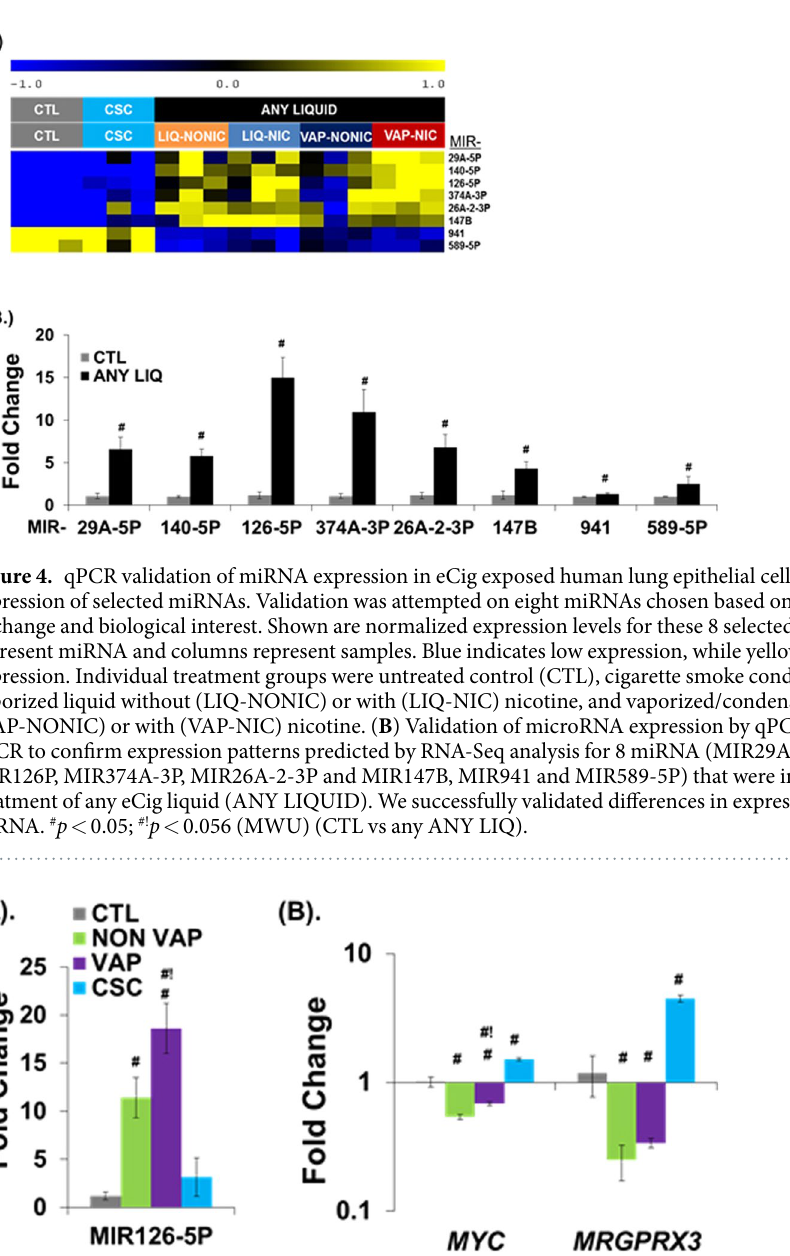
as compared to NON VAP exposure (15.6 fold in VAP vs 9.6 fold in NON VAP, p < 0.05). A modest increase in expression of MIR126-5P noted upon CSC treatment (2.6 fold) did not reach statistical significance. Next, we tested the expression levels of two MIR126-5P–specific target genes, MYC 31 and MRGPRX3 32 (Fig. 5B). Significant increases in MIR126-5P expression following NON VAP or VAP exposure was associated with significantly decreased expression of MYC (46% in NON VAP, 31% in VAP) and MRGPRX3 (75% in NON VAP, 66% in VAP), as compared to CTL cells. Conversely, in CSC treated cells, expression of MYC (1.49 fold, p < 0.05) and MRGPRX3 (3.7 fold, p < 0.05) paralleled the MIR126-5P expression.